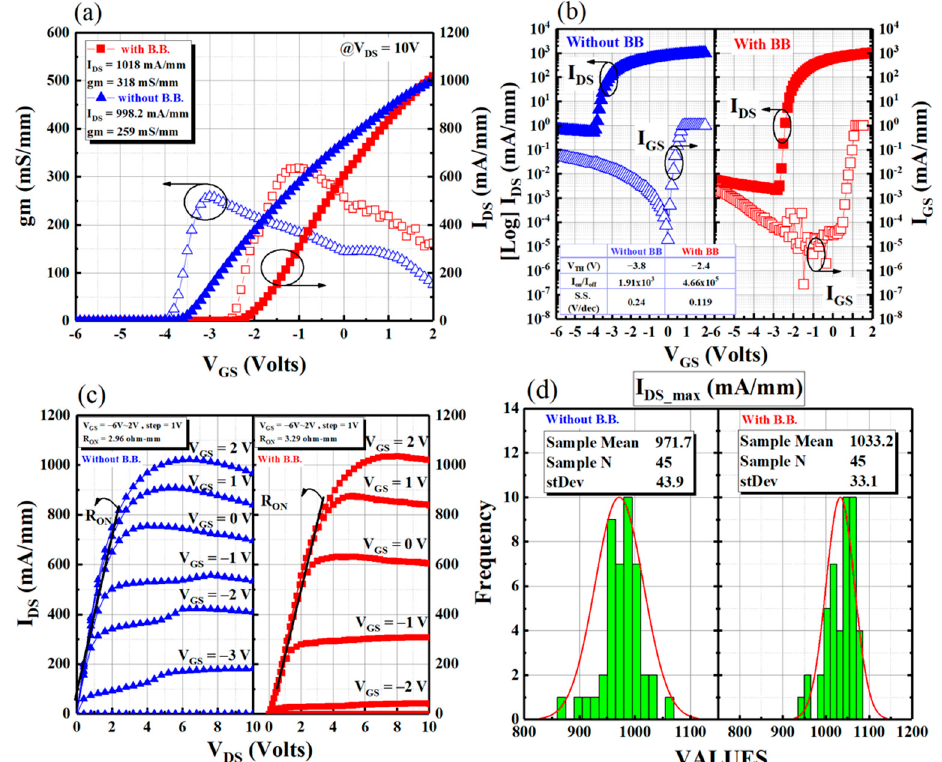
Figure 3. ( a )Transfer characteristics ( I DS – V GS ) at V DS = 10 V with a V GS sweep from − 6 to 2 V of device A and device B. ( b ) Off-state leakage current curve of the drain (log-scale I DS – V GS ) and gate ( I GS – V GS ). ( c ) Characteristics of the 0.25- µ m gate quaternary AlGaN/GaN HEMT I DS – V DS curve. ( d ) Histogram of saturated current measured in 45 devices.